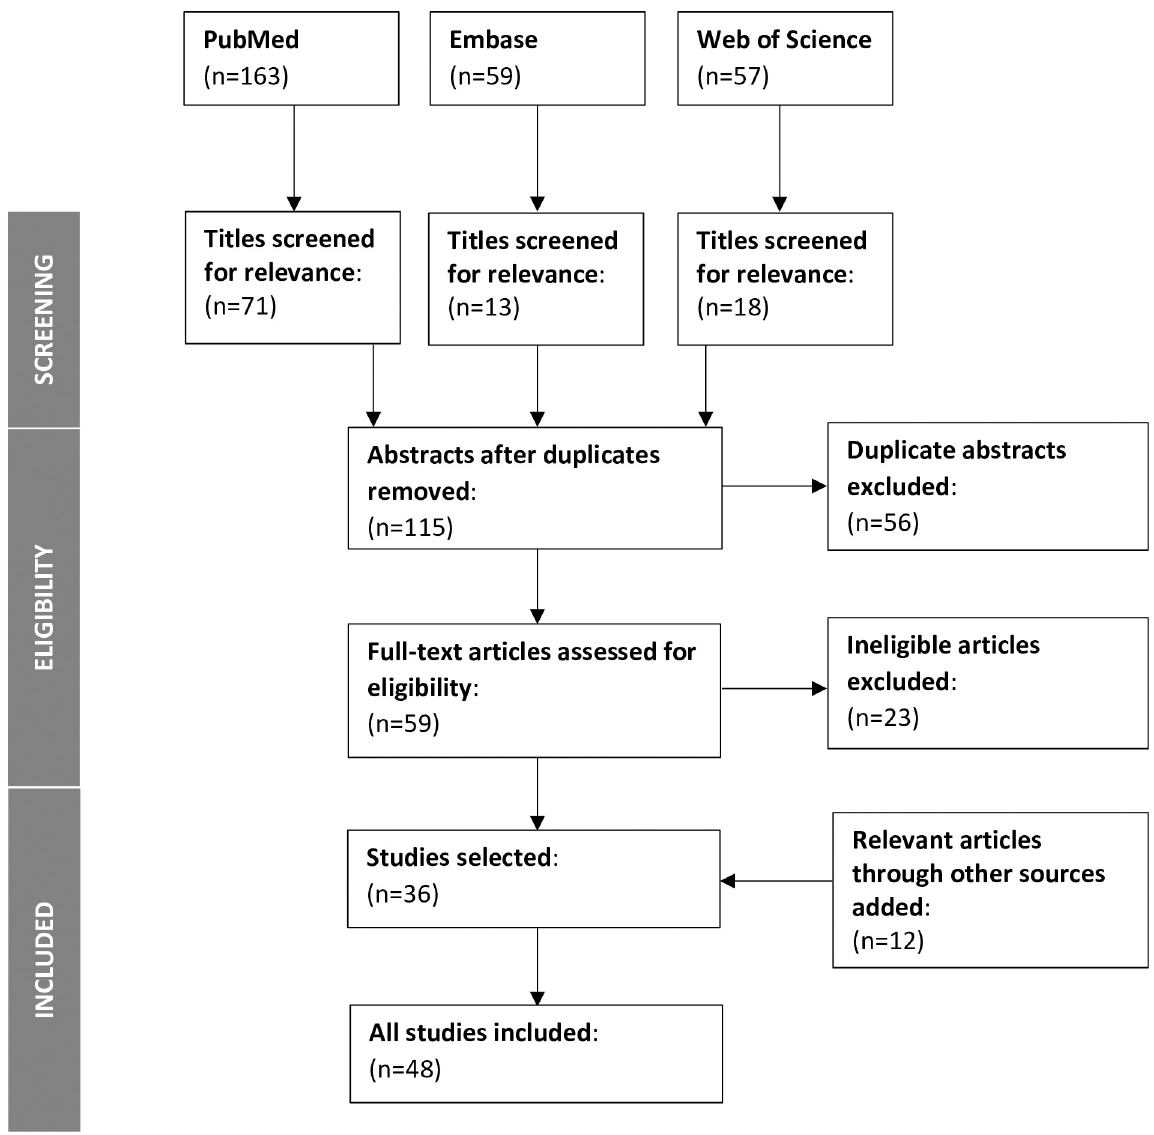
Fig 1. PRISMA flowchart of study selection